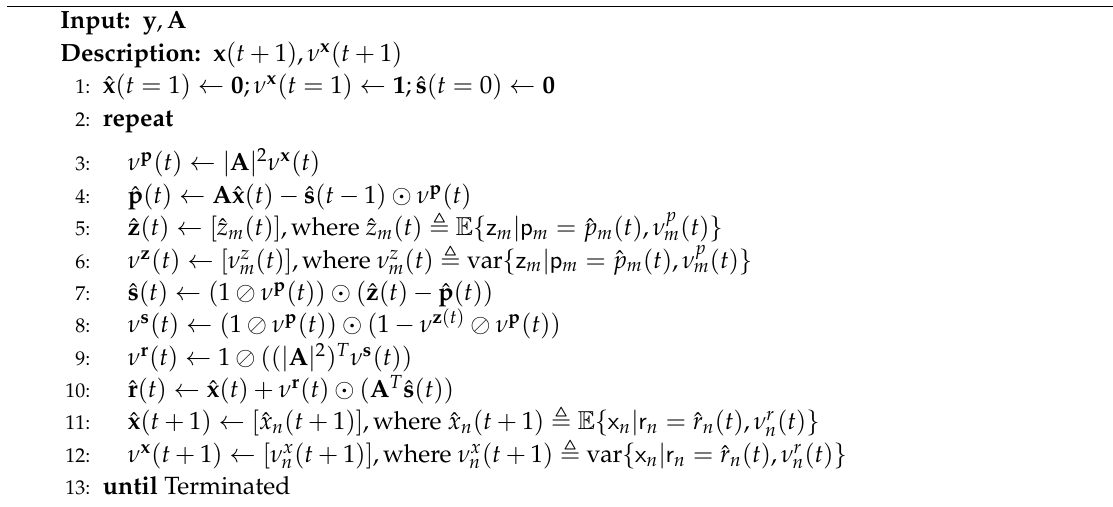
Algorithm 1: Generalized Approximate Message Passing